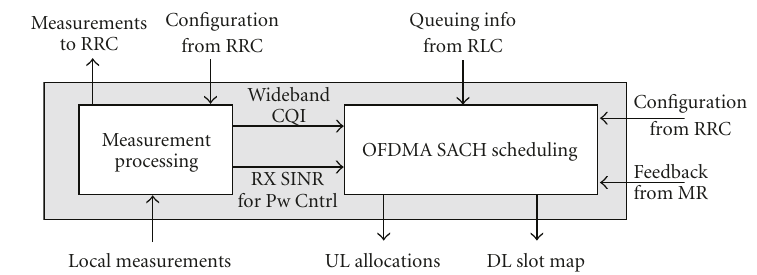
Figure 4: Overview of the MAC